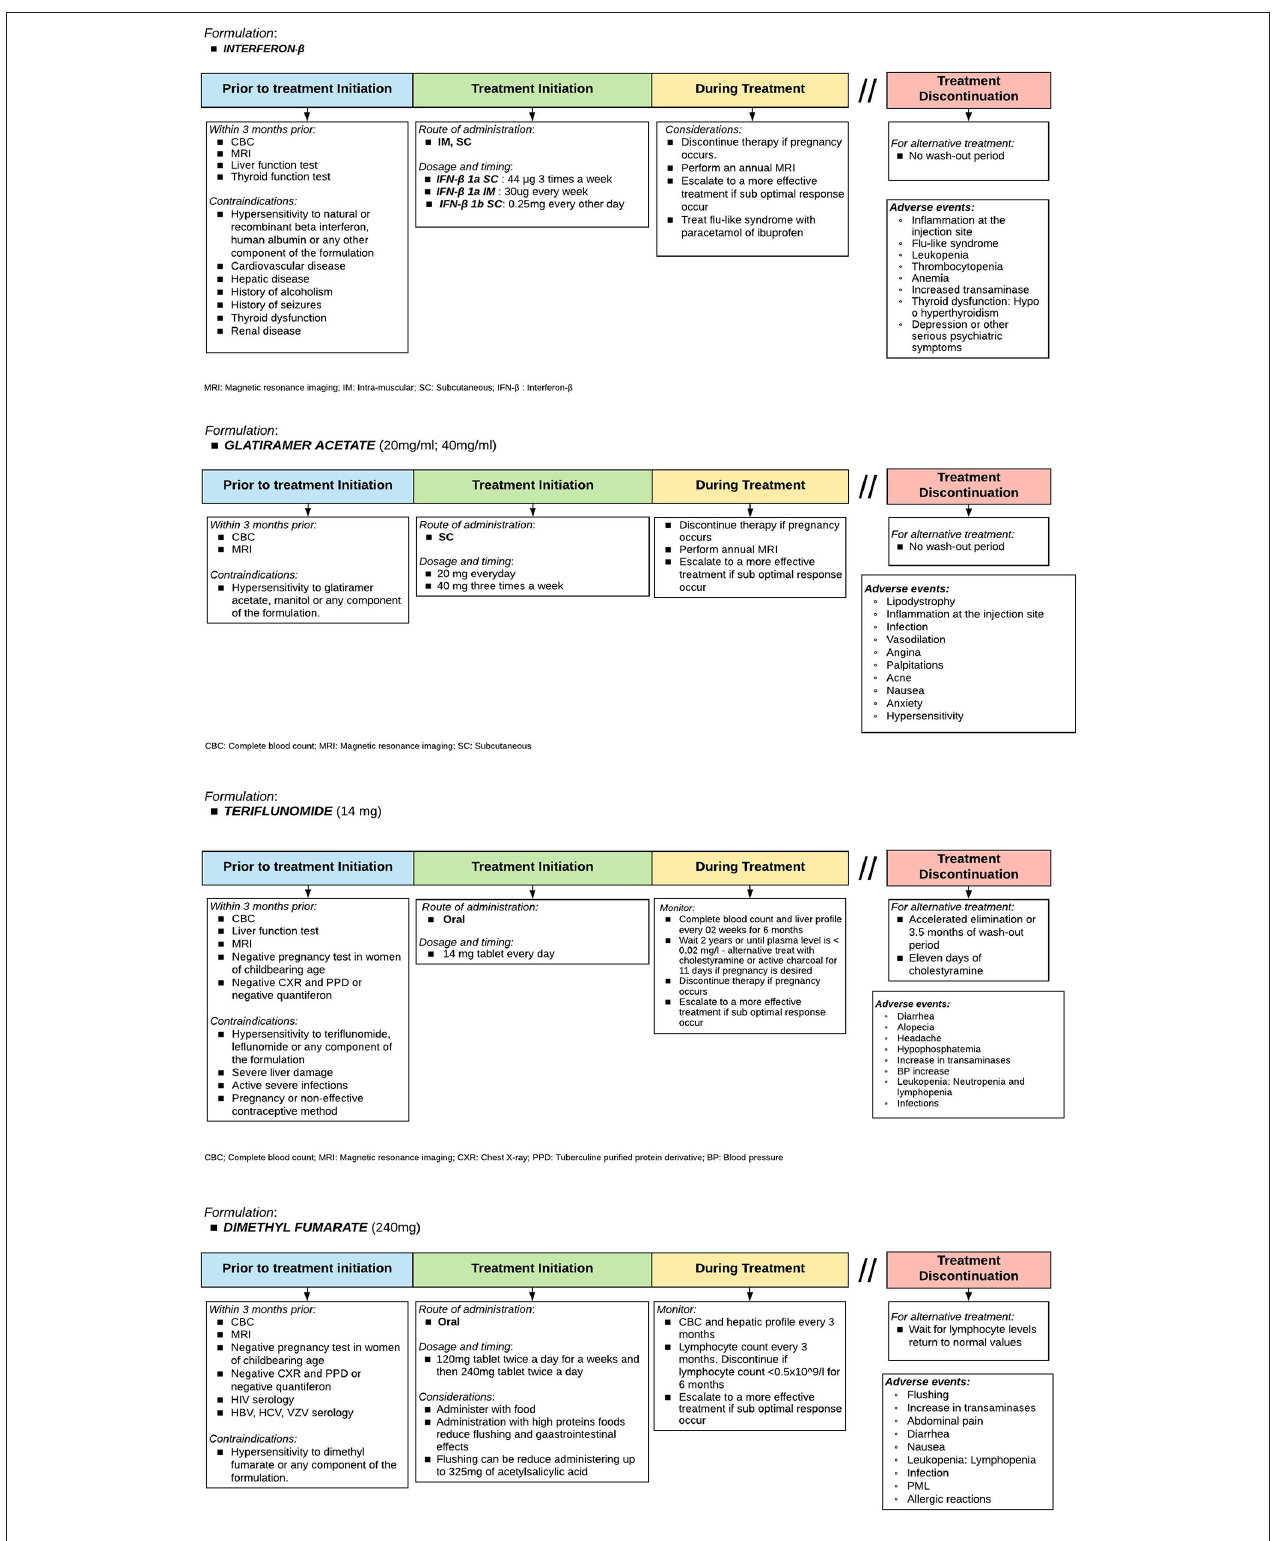
FIGURE 4 | Therapeutic protocol for induction: Interferon- β , glatiramer acetate, teriflunomide, and dimethyl fumarate. Adapted from Sorensen et al. (33).